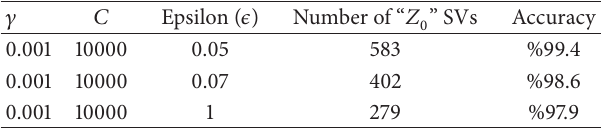
Table 2: SVRM parameters for coarse